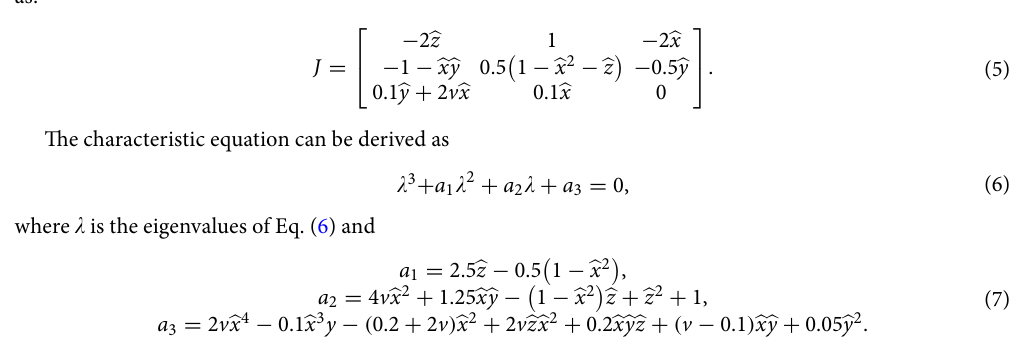
Figure 2. Numerically simulated equilibrium points and stability analysis with ν